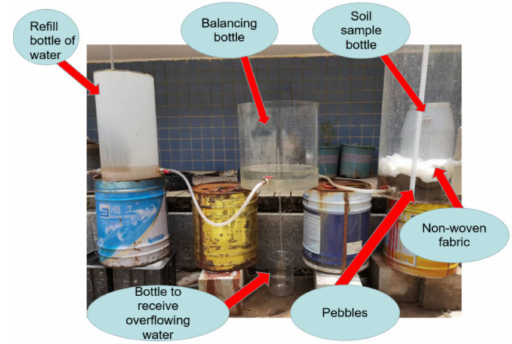
Figure 19. Soil infiltration device.